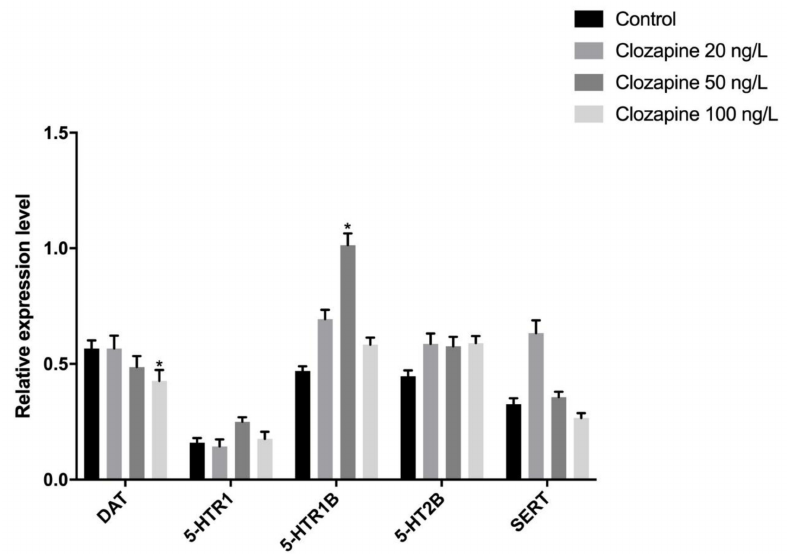
Figure 6. Clozapine exposure for 14 days induced changes in protein expression levels of functional molecules of DA and 5-HT neurotransmitter systems in octopus brain tissue. Note: * compared with the control group, p < 0.05; n = 5.